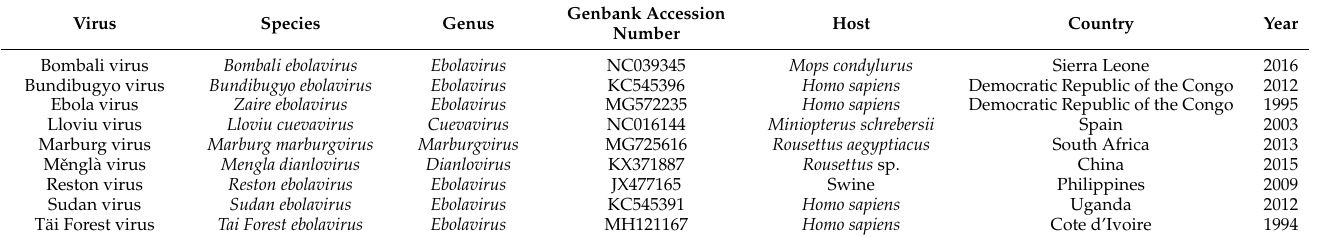
Table 1. Filovirus sequences representative of each mammalian filovirus species used for the syn- thetic constructs.